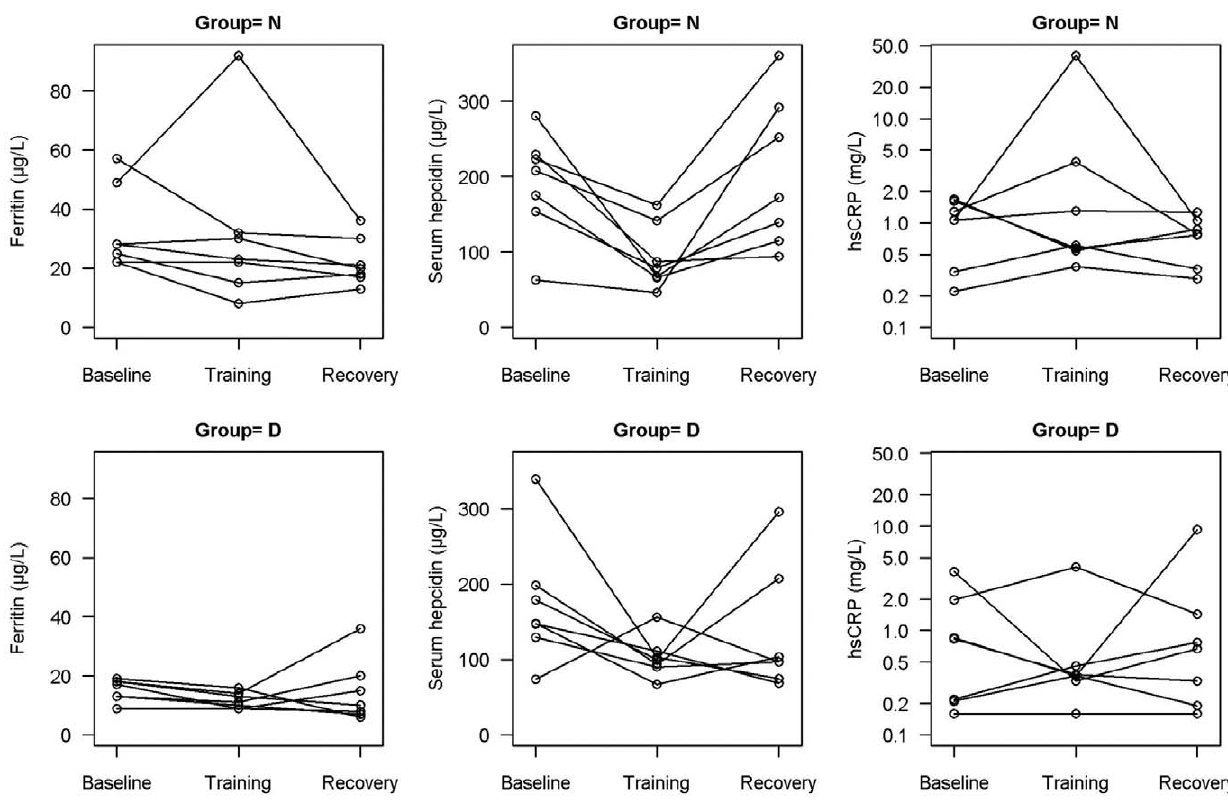
Table 3. Correlation between hepcidin level, iron status indicators and biomarkers of inflammation measured at baseline, after long-term training and after ten days of recovery.